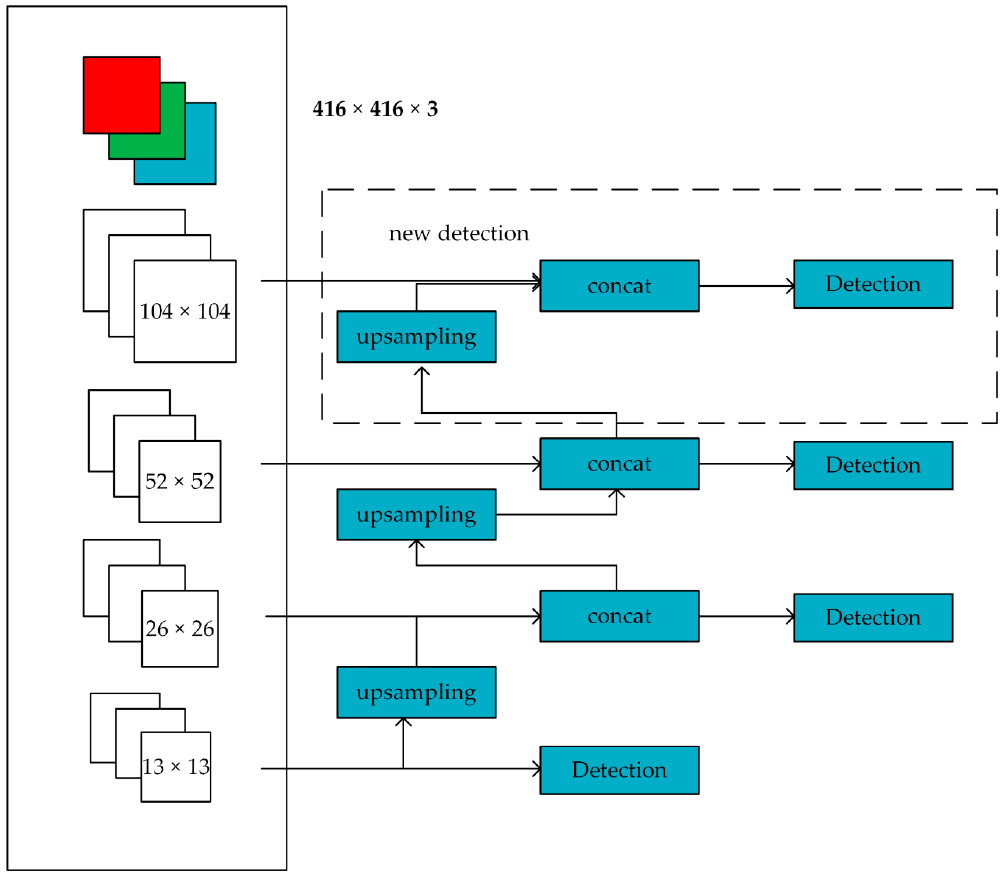
Figure 8. Scale detection module.